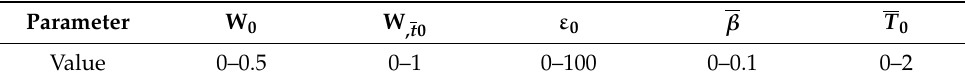
Table 2. Dimensionless